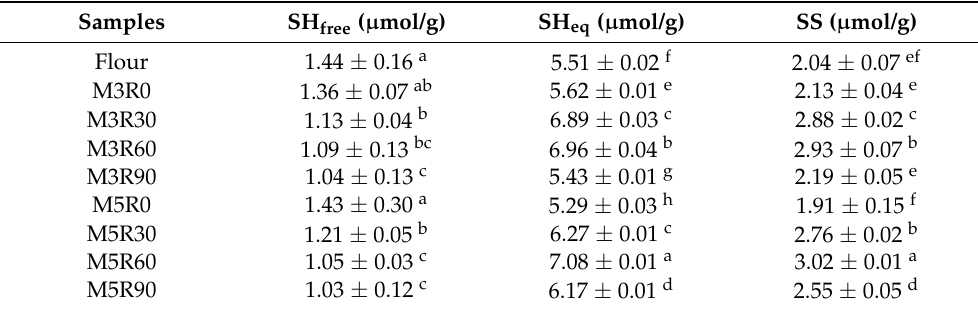
Table 1. Contents of accessible thiol (SH free ), total thiol equivalent (SH eq ), and disulfide bonds (SSs) of the GMP. Data are mean values ± standard variation of three replications and different letters indicate a significant difference at p <